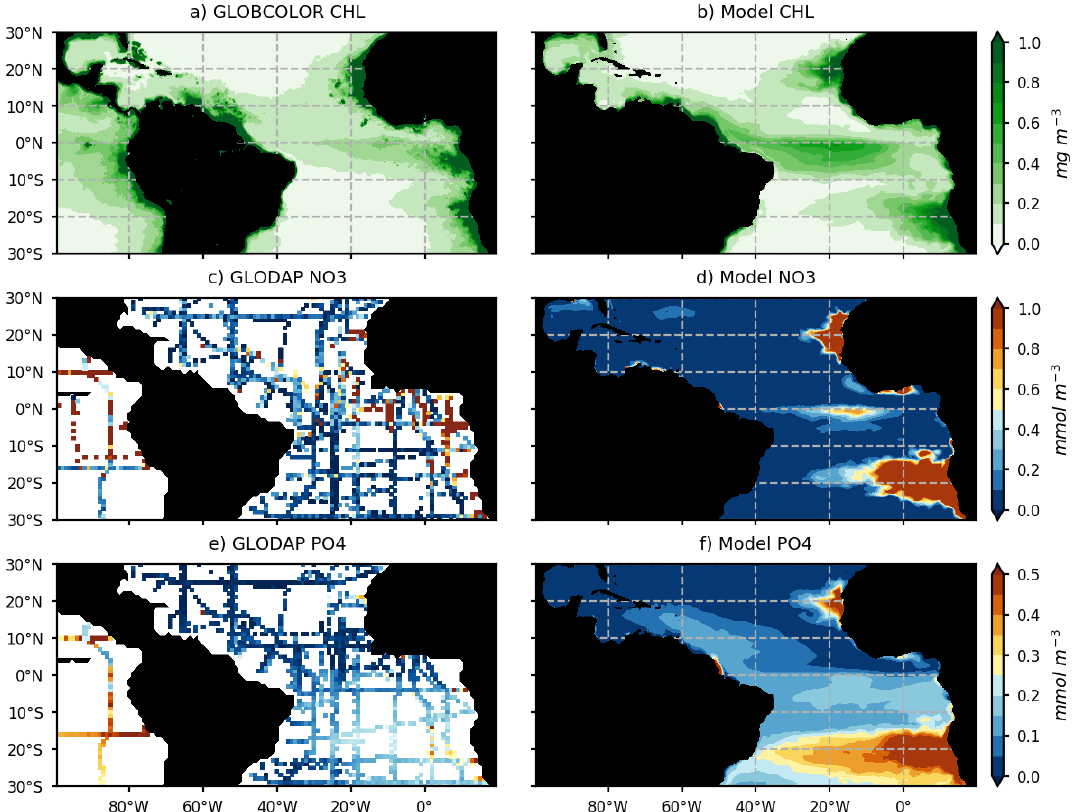
Figure 3. Annual mean surface chlorophyll concentrations (mgchl a m − 3 ) from the GlobColour satellite product (a) and model (b) for the year 2017. Spatial distribution of surface NO 3 and PO 4 concentration ( c, e ; mmolm − 3 ) from historical cruises of the GLODAPv2_2016 database (https://www.nodc.noaa.gov/ocads/oceans/GLODAPv2/, last access: 1 June 2020) and annual mean surface NO 3 and PO 4 distribu- tion from the model (d, f)